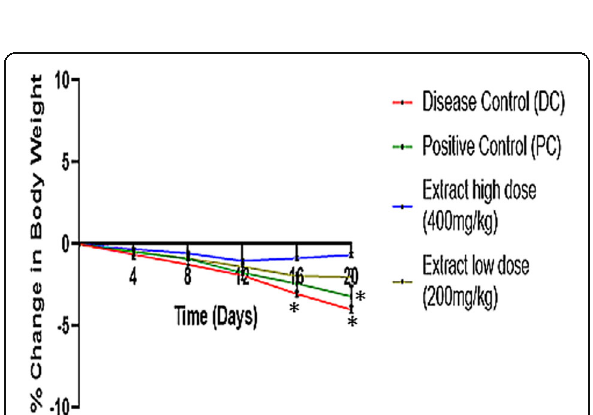
Fig. 6 Graphical representation of body weights. Results are represented as mean ± SD. The asterisk represents significant reduction body weight of DC and PC groups on day 20 in comparison with day 0. No significant changes in body weights was observed in mice receiving MEUP. ( P <